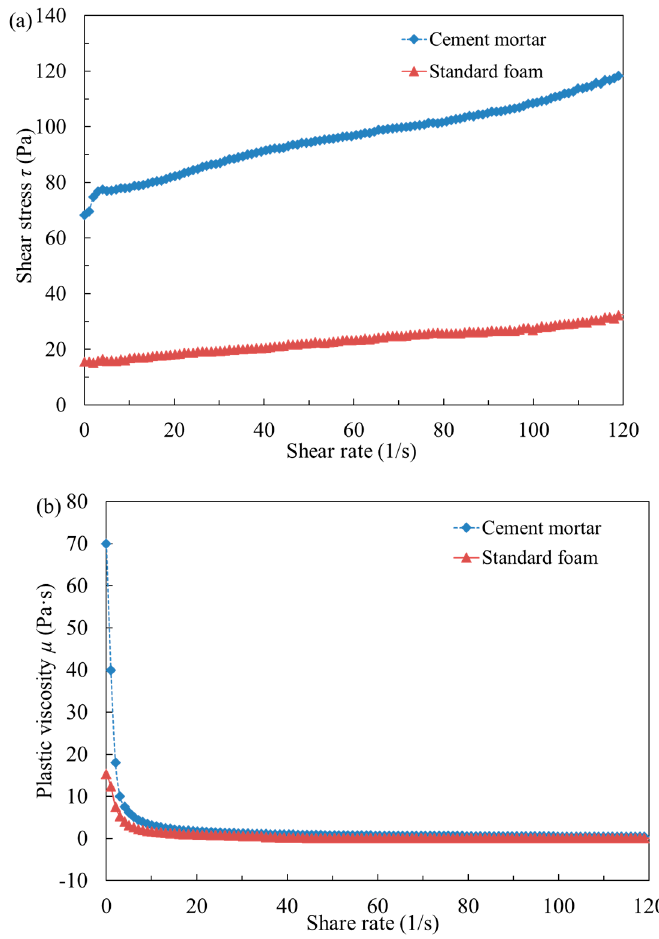
Table 1. The rheological properties of the cement slurry and standard foam.